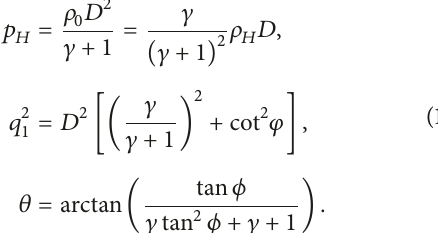
The detonation wave propagation is in the form of a regular oblique reflection wave as shown in the oblique reflection of Figure